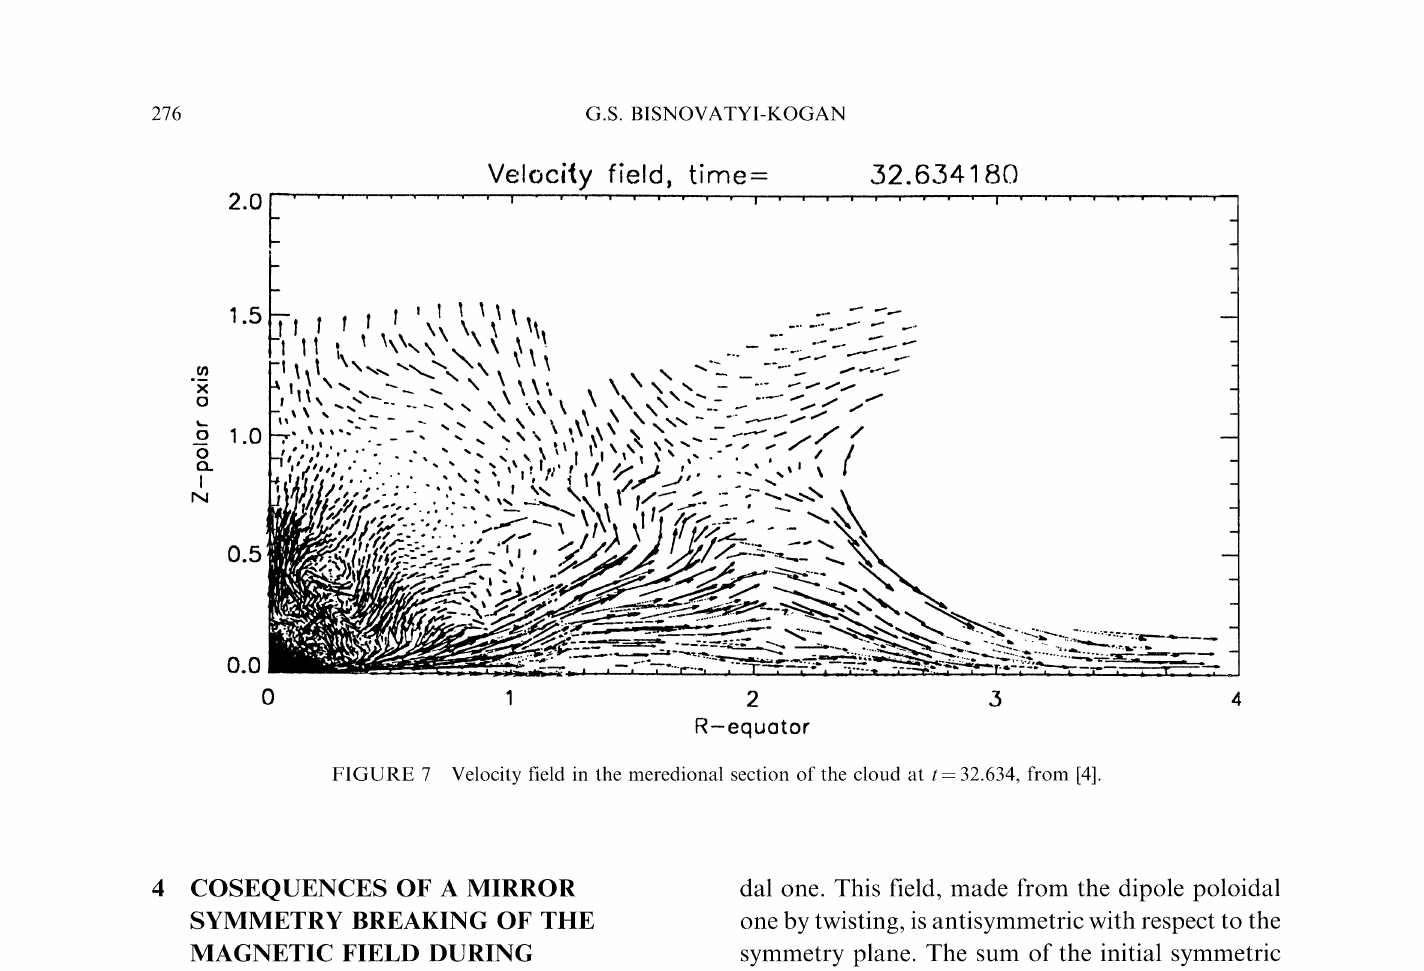
R-equotor FIGURE 7 Velocity field in the meredional section of the cloud at 32.634, frol-n